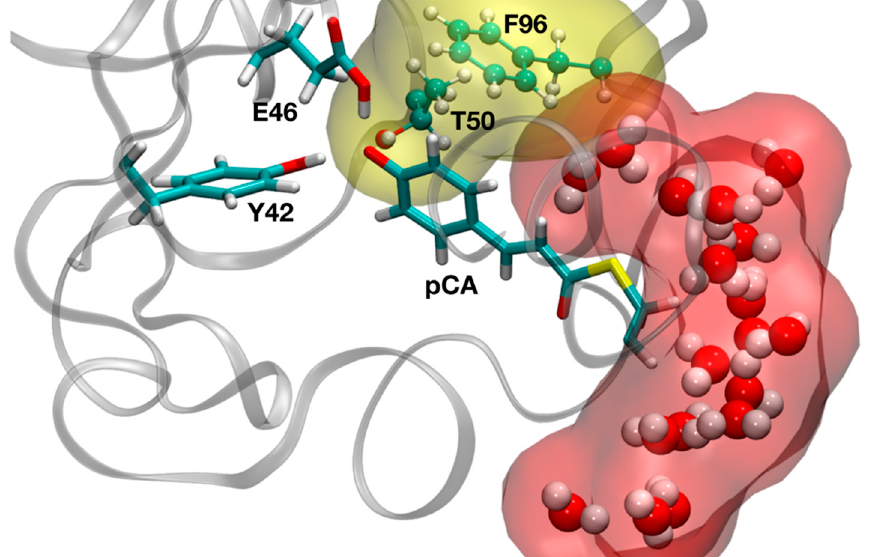
Figure 3. Representative snapshot from the classical MD simulation showing the orientation of T50 and F96 side chains, which impede the entrance of water molecules deeply into the region where the short hydrogen bonds (HBs) are located.